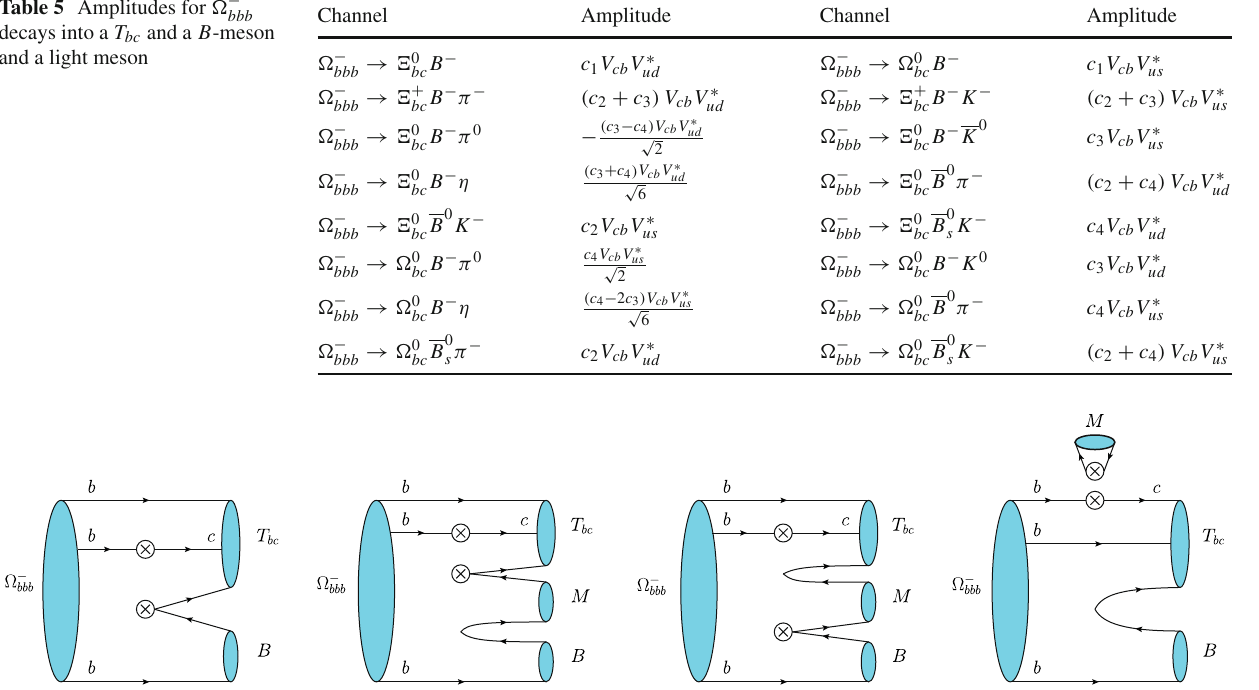
Channel Amplitude bbb